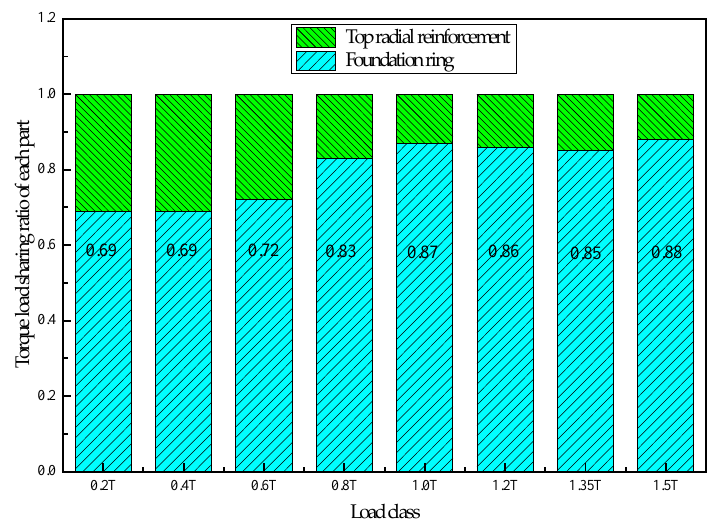
Figure 15. Torque load sharing ratio of specimen ZT-4.